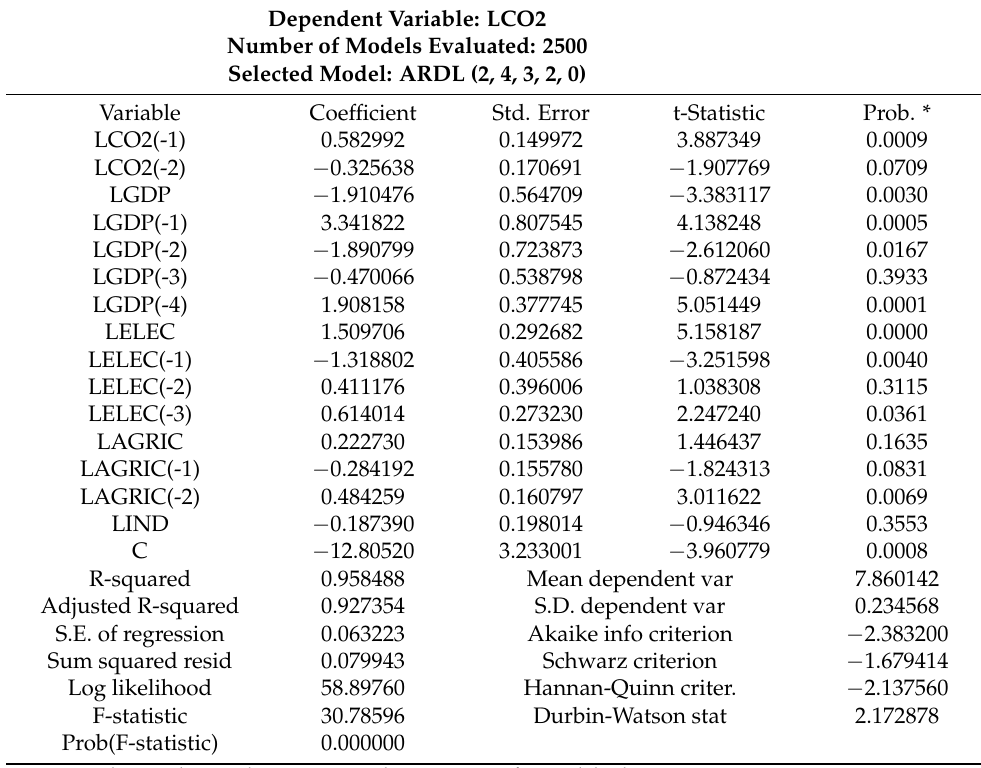
Table A1. ARDL estimation output